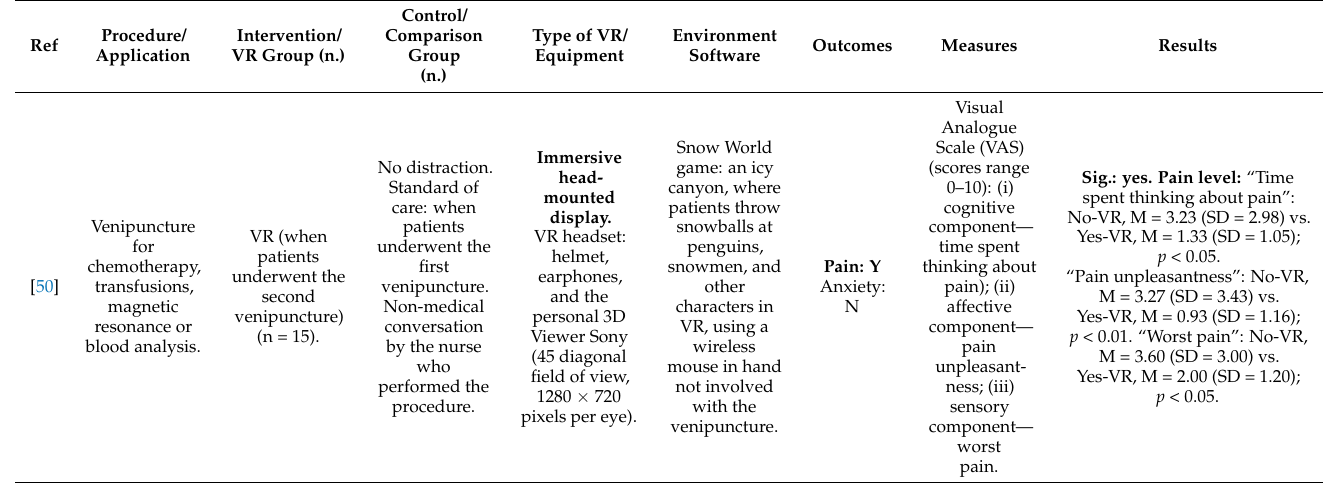
Table 5. Summary of the main results of included